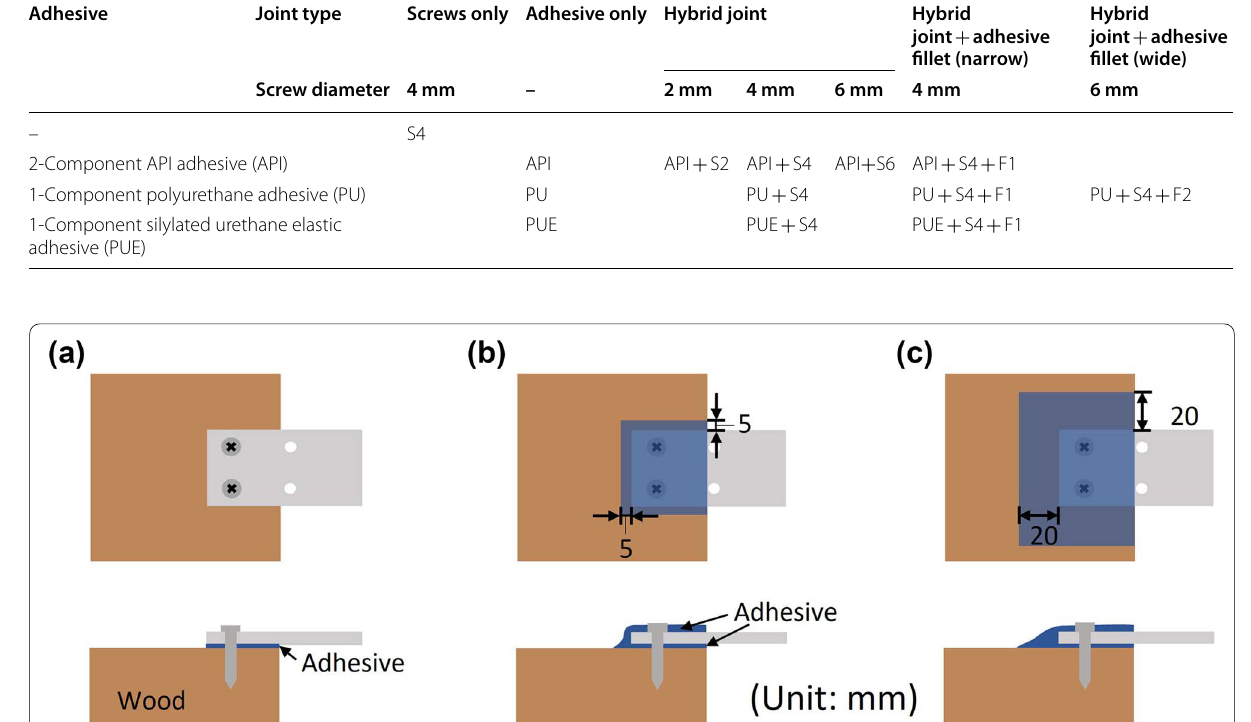
Fig. 3 a Standard hybrid joint, b hybrid joint